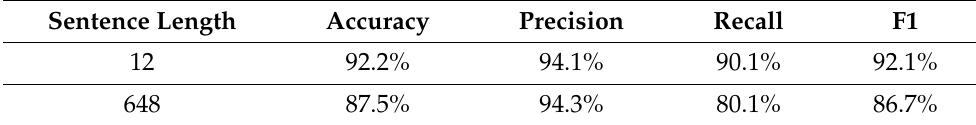
Table 3. Experimental results of text